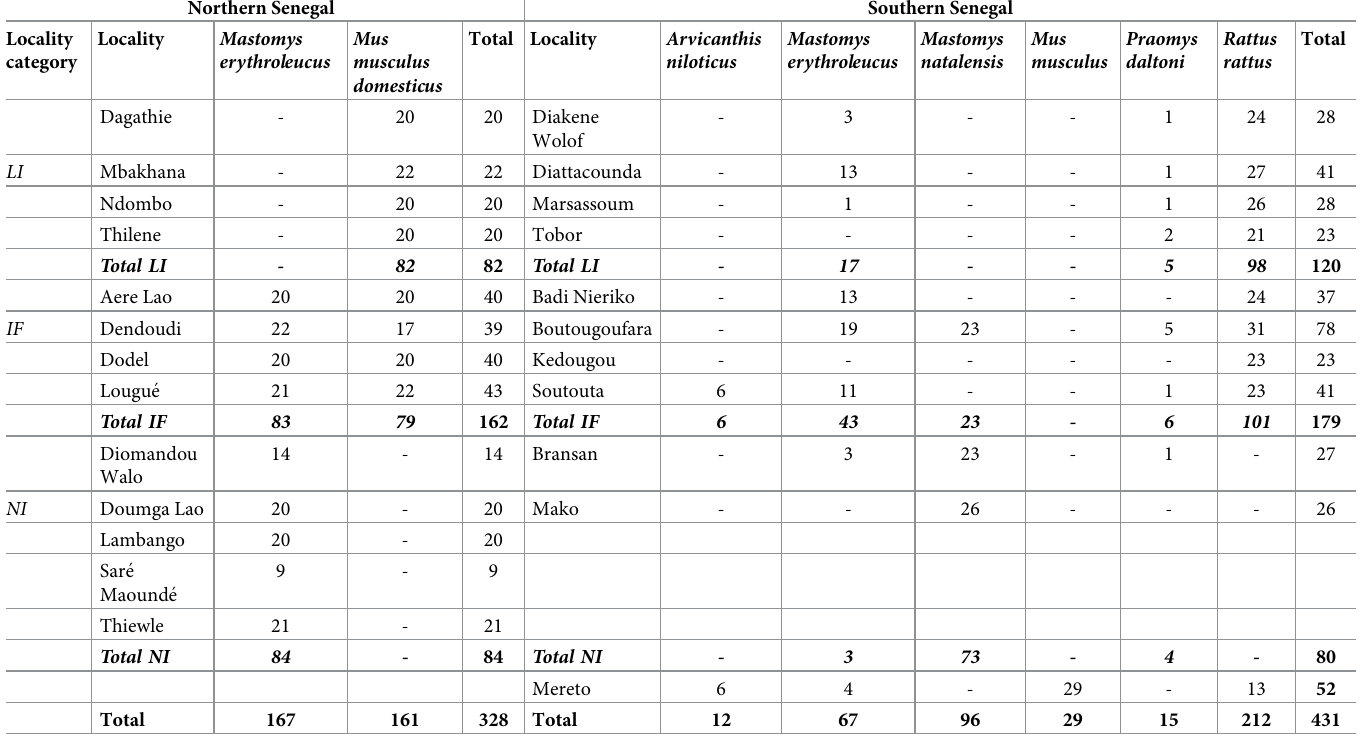
Table 1. Summary of rodents trapped in localities of Mus musculusdomesticus or Rattusrattus long-established invasion (LI), invasion front (IF) and no invasion (NI). Northern Senegal Locality category